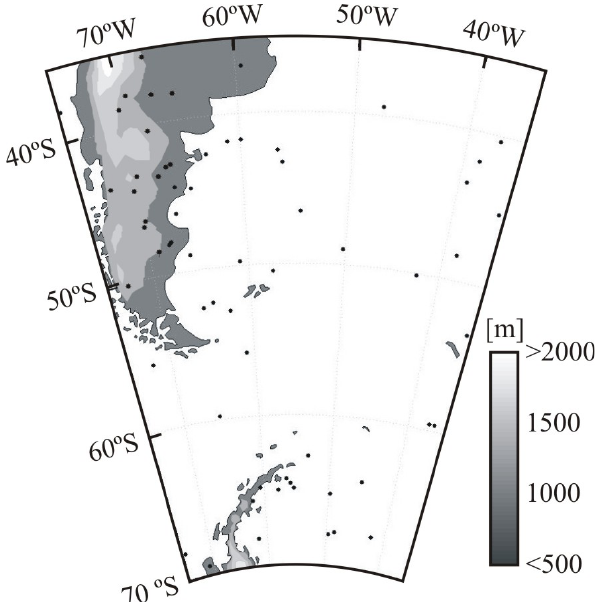
Fig. 4. Geographical distribution of events with E p > 4J/kg. To- pography has been included for reference.